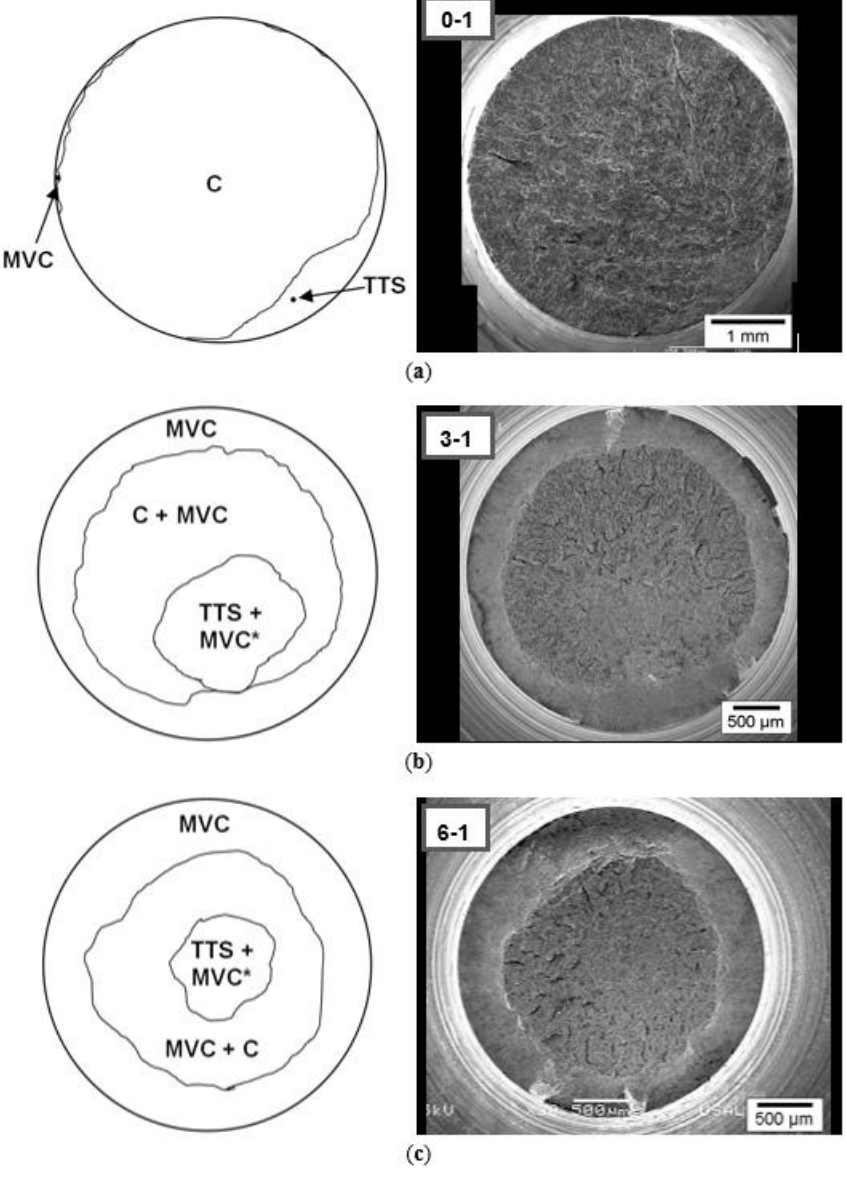
Figure 4. Micro-fracture maps (MFMs) for low loading rate (crosshead speed type 1 of 0.001 mm/min): ( a ) hot rolled steel (base material that is not cold drawn at all); ( b ) three drawing steps; ( c ) six drawing steps (heavily-drawn commercial prestressing steel).